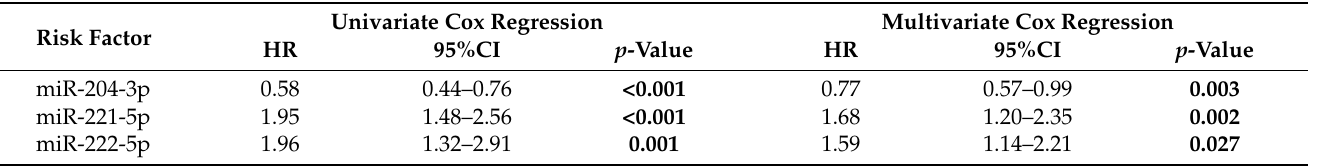
Table 5. Cox proportionate hazard regression analysis.